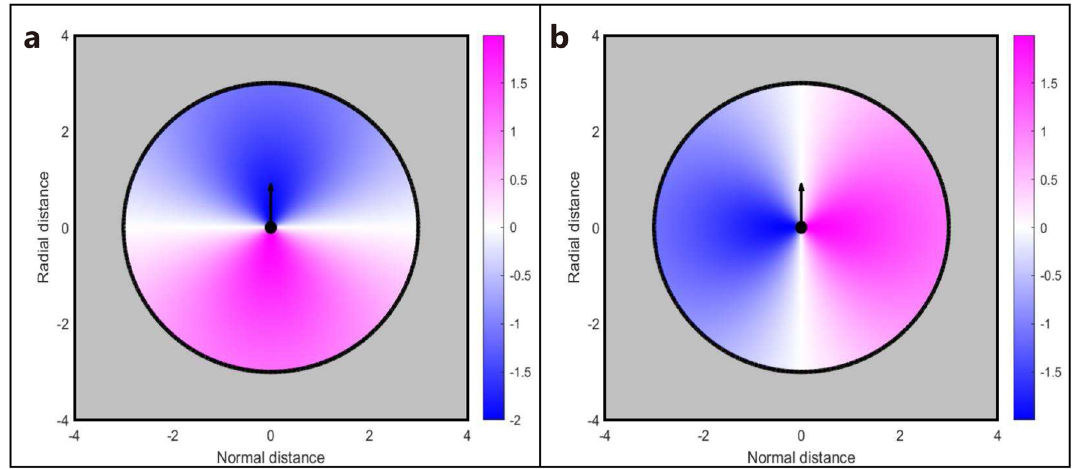
Fig. 4 Schematic diagram of the obstacle avoidance function of the visual perception term. a represents the change of the projection of the field of view of the obstacle located in front of and behind the drone i . The black arrow indicates the velocity direction of the drone i . The